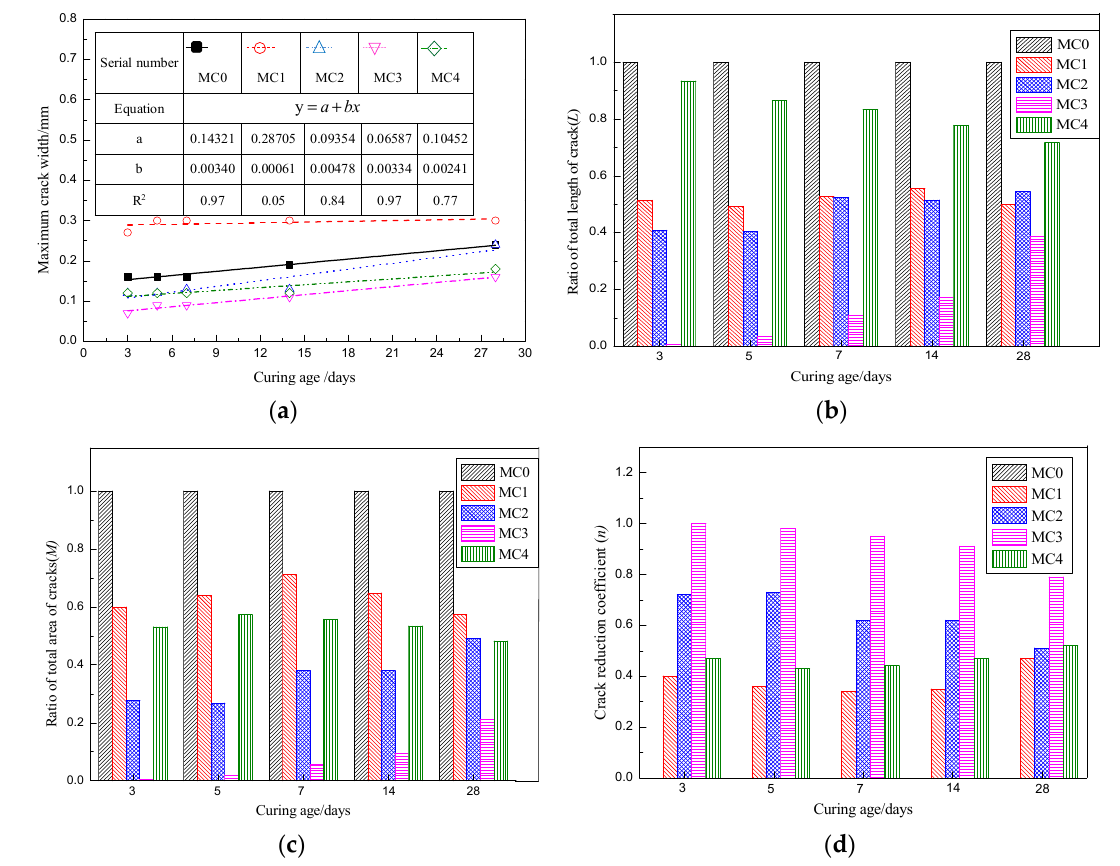
Figure 3. Maximum crack width, L , M , n , and age: ( a ) maximum crack width; ( b ) total crack length ratio L ; ( c ) total cracking area ratio M ; ( d ) crack reduction coefficient n . Table 5. Mechanical properties under various curing